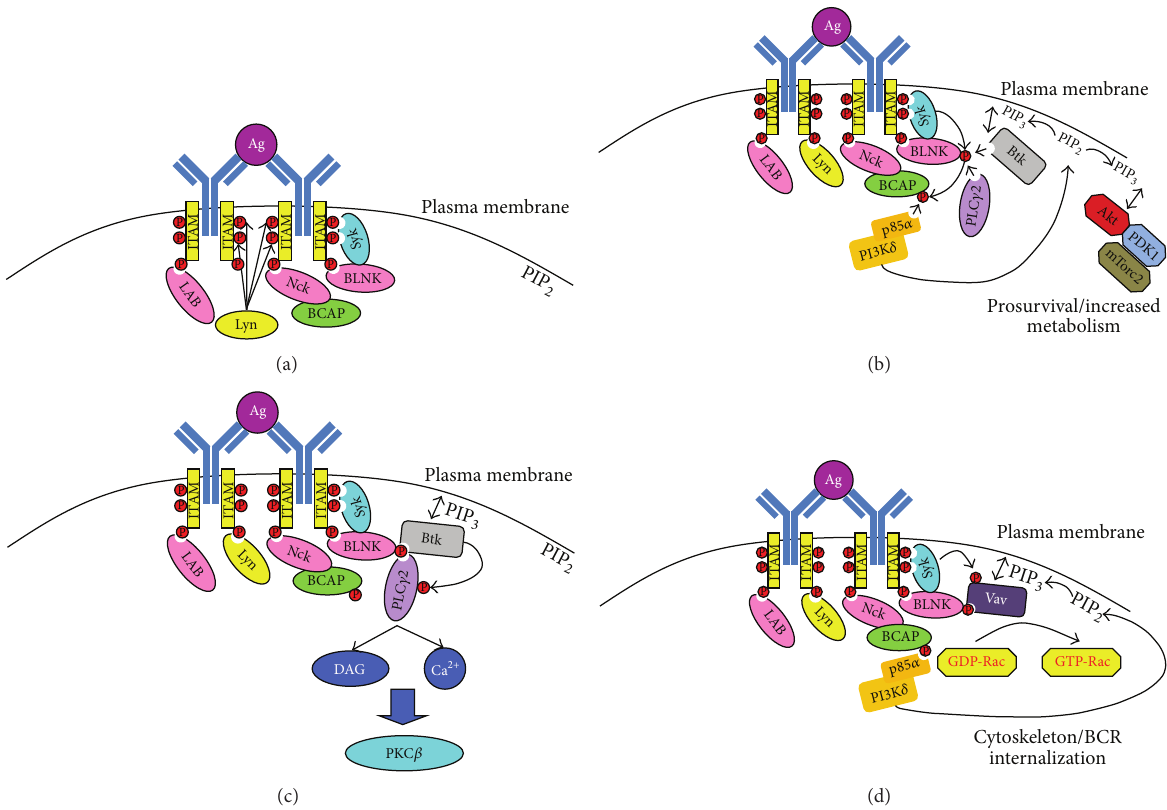
Figure 1: Induction of proximal BCR signaling. Illustration of the most proximal signals initiated during BCR engagement. (a) Antigen engagement of the BCR induces Lyn-mediated phosphorylation of CD79 on tyrosine residues within and outside the ITAM motif. This attracts adaptor molecules such as LAB, Nck, BCAP, and BLNK, as well as the tyrosine kinase Syk. (b) Syk binding to tyrosine phosphorylated CD79 induces its activation, and it phosphorylates BLNK, BCAP, and LAB. Phospho-BCAP attracts and activates PI3K 𝛿 and converts PIP 2 to PIP 3 . The presence of PIP 3 on the plasma membrane attracts PDK1 and Akt; PDK1 phosphorylates and activates Akt, and this is followed by a second phosphorylation event by mTorc2. PIP 3 on the plasma membrane also attracts Btk, which then binds to phospho-BLNK and exposes a phosphorylation site for Syk leading to autophosphorylation and full activation of Btk [17]. Phospho-BLNK also acts as a scaffold for PLC 𝛾 2. (c) Active Btk phosphorylates and activates PLC 𝛾 2 and catalyzes the conversion of PIP 2 to DAG and IP 3 (which acts on ER to release intracellular Ca 2+ ). DAG and Ca 2+ then act to activate PKC 𝛽 . (d) Phospho-BLNK and phospho-LAB serve as scaffolds for Vav,